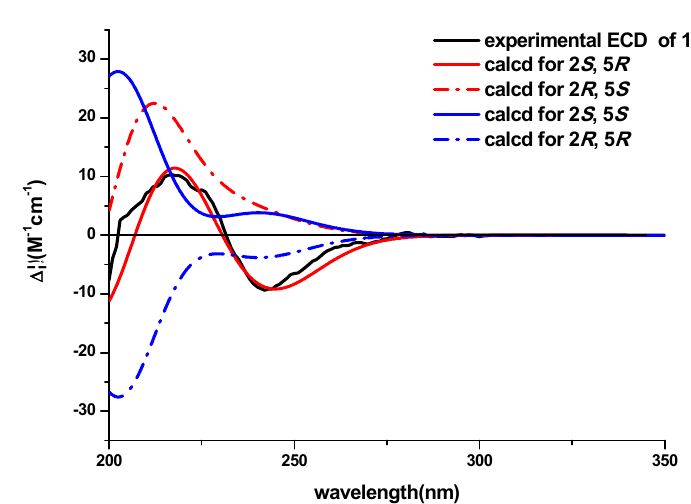
Figure 3. Comparison of the experimental ECD spectra of 1 with the calculated ECD spectra for four stereochemical options. Table 1. 1 H- and 13 C-NMR Data (400 and 100 MHz, resp. δ in ppm) of compounds 1 and 3